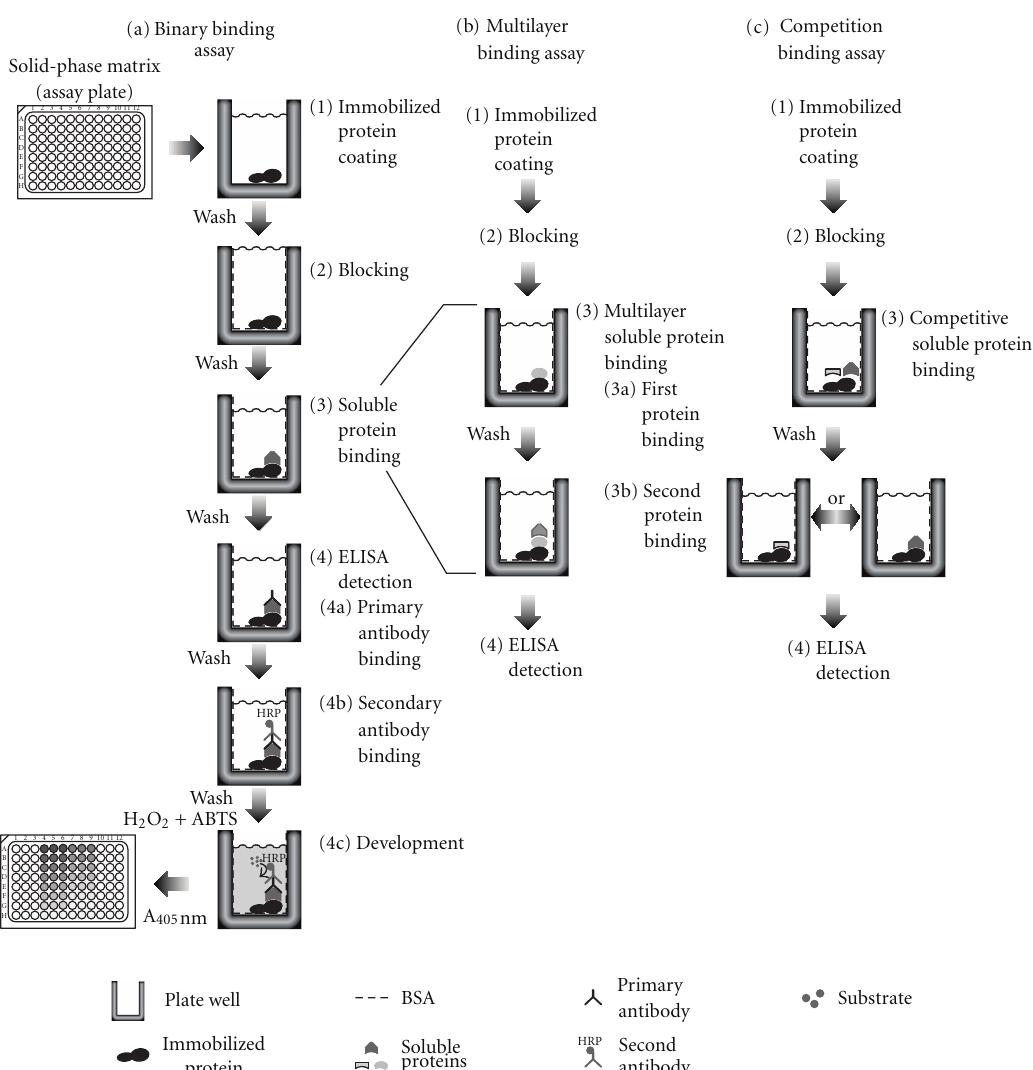
Figure 1: Solid-phase protein-binding assay method. (a) Binary binding assay to quantify the interaction between an immobilized protein and an interacting soluble protein. (1) The immobilized protein of interest is maximally coated into the wells of a 96 well assay plate. (2) Unbound protein is removed by washing, and remaining surfaces blocked with a nonspecific protein. (3) The plate is washed, and binding is evaluated by incubation with serial dilutions of a soluble interacting protein. (4) Following another wash to remove unbound interacting protein, bound protein is detected by ELISA with a primary antibody against the interacting protein, a HRP-conjugated second antibody and substrate development to quantify bound protein by absorbance. (b) Multilayer binding assay to quantify the interaction between an immobilized protein and two related interacting soluble proteins. The multilayer protein binding is conducted similar to the binary binding assay in (a) with the exception that, following binding of the first soluble protein and washes, the wells are incubated with another protein that binds the first protein bound to the immobilized protein followed by ELISA quantification. (c) Competitive binding assay to quantify the interaction between an immobilized protein and an interacting soluble binding protein in the presence of varied amounts of a second binding protein. Protein coating and blocking are conducted as in (a) and (b) with the exception that during the soluble protein binding step, addition of the first interacting protein of interest is conducted at a constant concentration in the presence of serial concentrations of a competitive binding protein. Resultant binding of the constant concentration of the first binding protein of interest to the immobilized protein is then quantified by ELISA with a specific antibody. ELISA quantification of the degree of competition will be detected by decreases in the final reading of